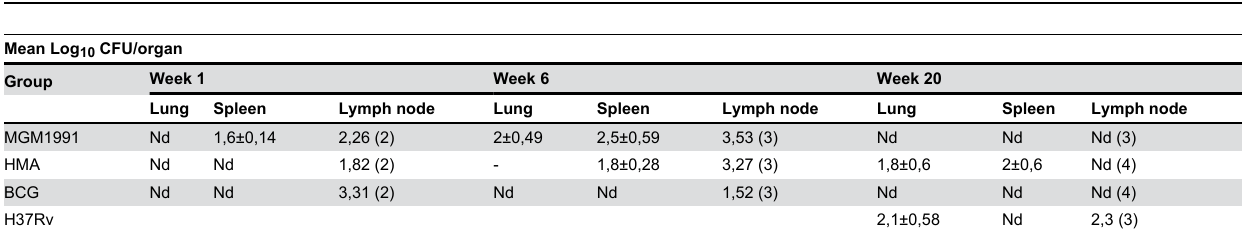
Table 1. Bacterial load in lungs, spleen and inguinal lymph nodes at weeks 1, 6 and 20 after subcutanous immunization with MGM1991, HMA, M. bovis BCG or M.tuberculosis